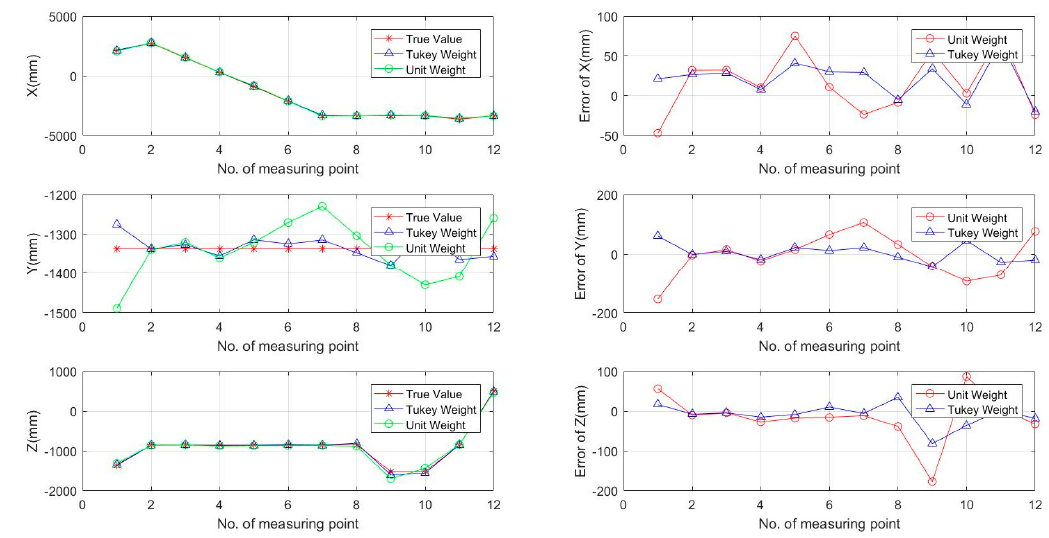
Figure13. Themovingtrajectoryoftheplatformandtheaccuracycomparisonbetweenthetwomethods. Figure 13. The moving trajectory of the platform and the accuracy comparison between the two methods. Table 3. Results of experiment 2.